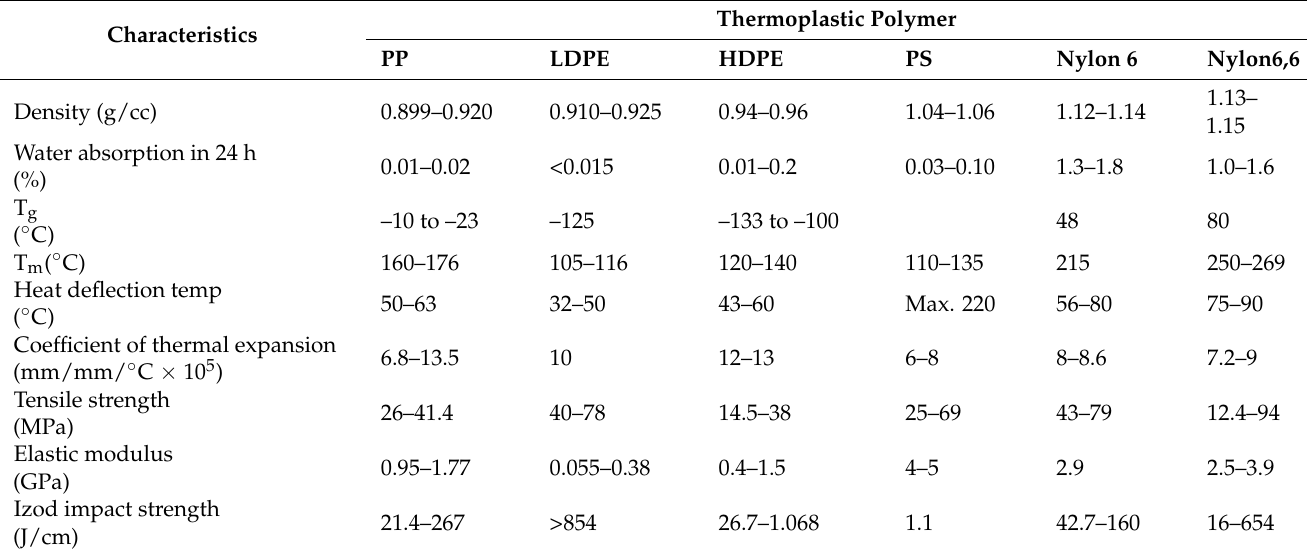
Table 3. General characteristics of thermoplastic polymer